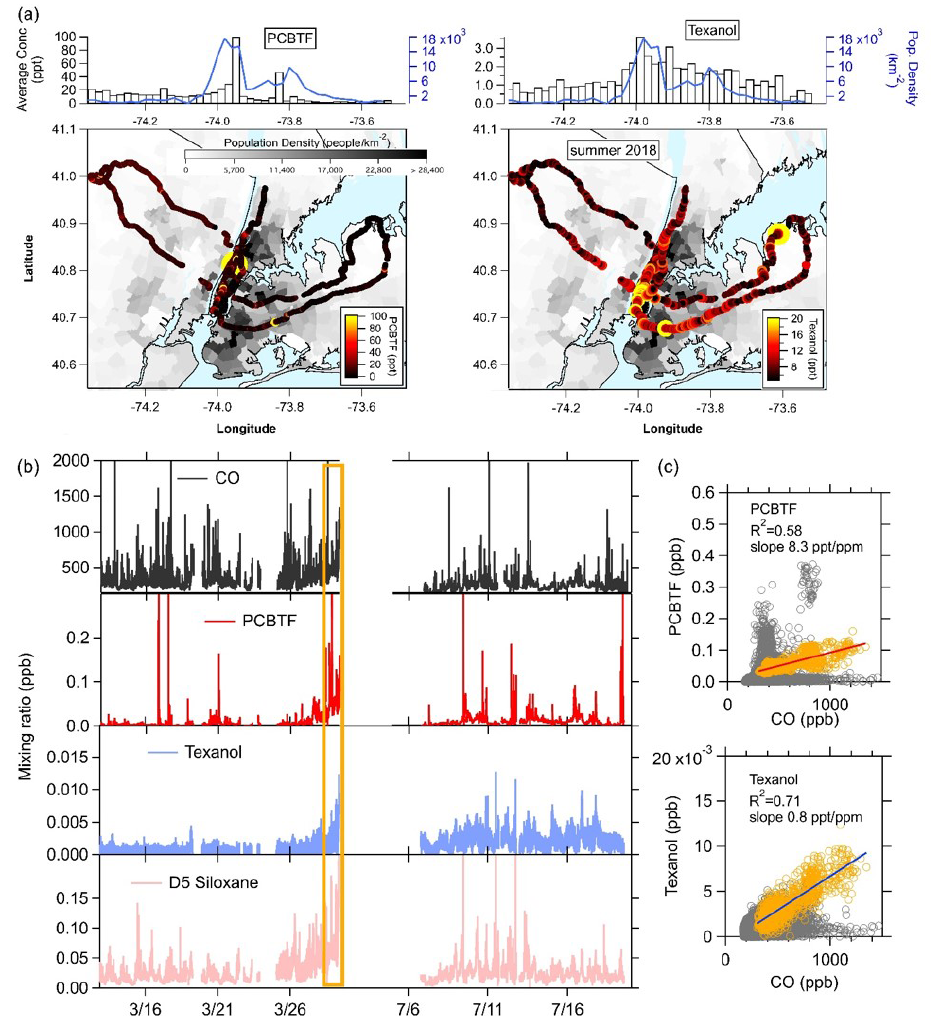
Figure 1. Summary of the PCBTF and Texanol measurements in New York City. The maps show the color-coded NOAA Mobile Laboratory drive track overlain on a map of the population density. (a) Binned population density and mixing ratios. (b) Time series of CO, PCBTF, Texanol, and D5 siloxane for the winter and summer months. The stagnation period during winter measurements is highlighted in orange. (c) The correlation plots of PCBTF and Texanol with CO for winter measurements. Slopes are calculated for the stagnation period at the end of the winter measurements (orange